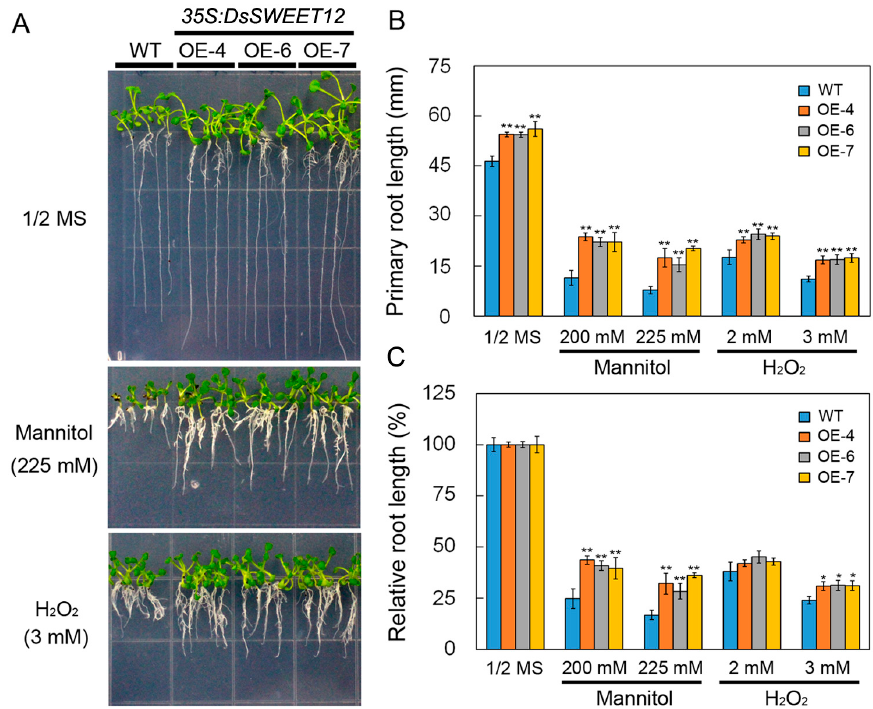
Figure 6. Phenotypes of wild type (WT) and DsSWEET12 transgenic Arabidopsis under various stresses. Seedling growth ( A ), root length ( B ), and relative root length ( C ) of WT and three transgenic lines on 1/2 MS (Murashige and Skoog) medium supplemented with mannitol (200 and 225 mM), H 2 O 2 (2 and 3 mM), and NaCl (125 mM). Asterisks indicate significant differences between WT and transgenic lines (* p < 0.05; ** p < 0.01; Student’s t test). Error bars show the SE of the values from three replicates.